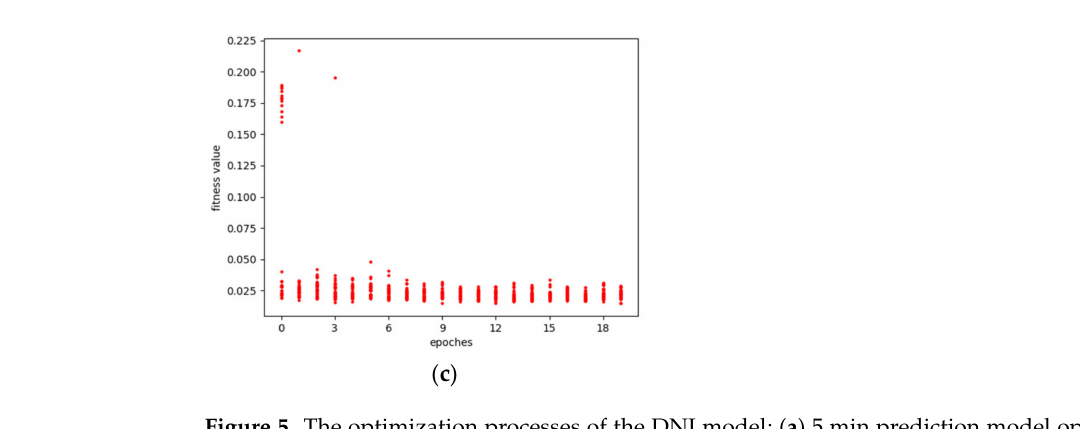
Figure 5. The optimization processes of the DNI model; ( a ) 5 min prediction model optimization process; ( b ) 10 min prediction model optimization process; ( c ) 15 min prediction model optimization process.